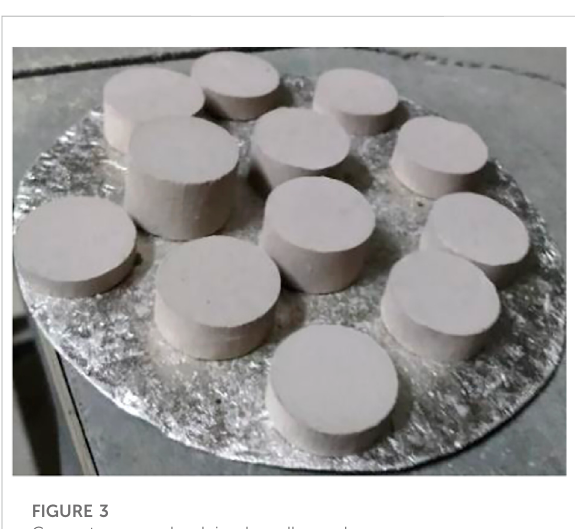
FIGURE 3 Cement raw meal-calcined small samples.